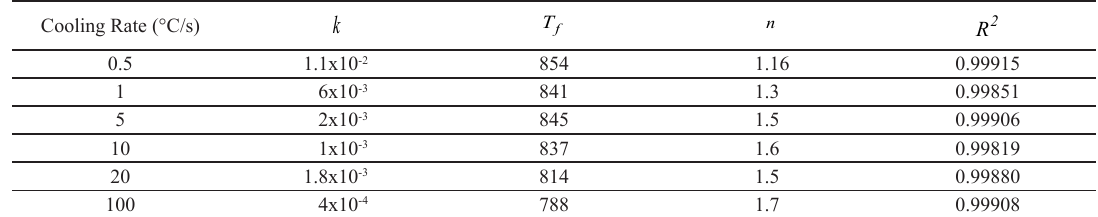
Figure 6. Phase fractions as a time function for IF-Ti steel cooled at 0.5 °C/s. Comparison between Ferrite-time and JMAK fittings. Table 3. Kinetics constants obtained by the fitting of Equation 3 to the experimental data.